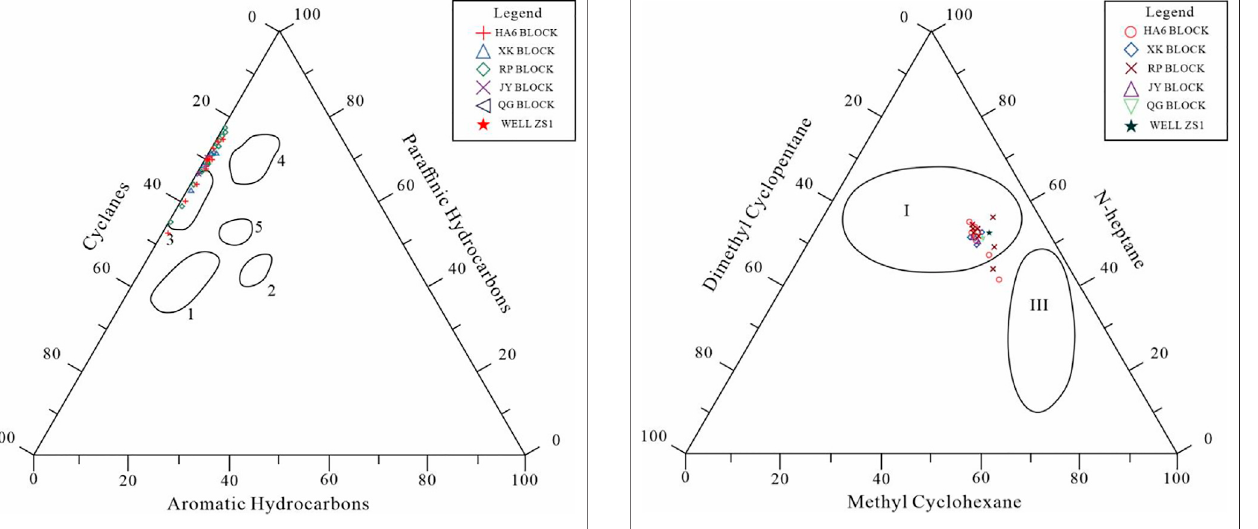
FIGURE 4 | Triangular plot of C 4 -C 7 light hydrocarbon family components of Halahatang Ordovician crude oil. Note: Regions 1 and 2: humic kerogen; Regions 3 and 4: sapropelic kerogen; Region 5: mixed kerogen.